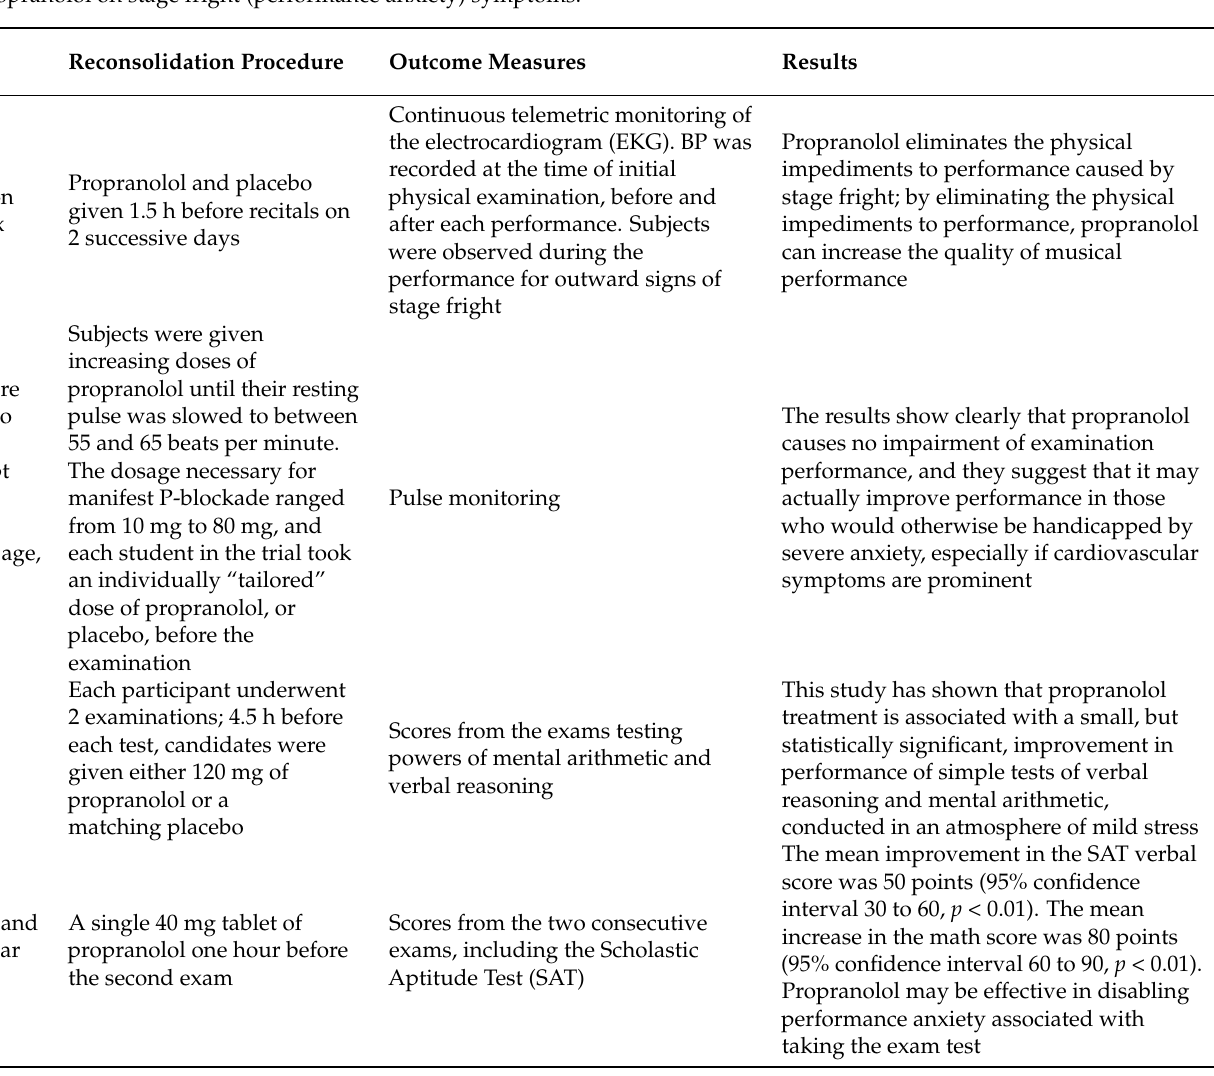
Table 1. Studies evaluating effect of propranolol on stage fright (performance anxiety)